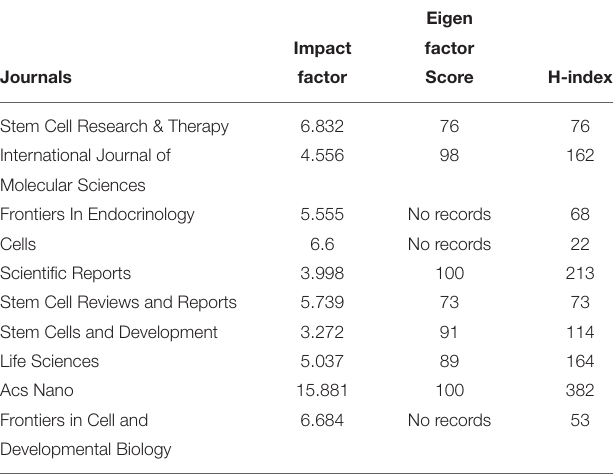
TABLE 3 | Impact index of the top 10 journals with the largest number of